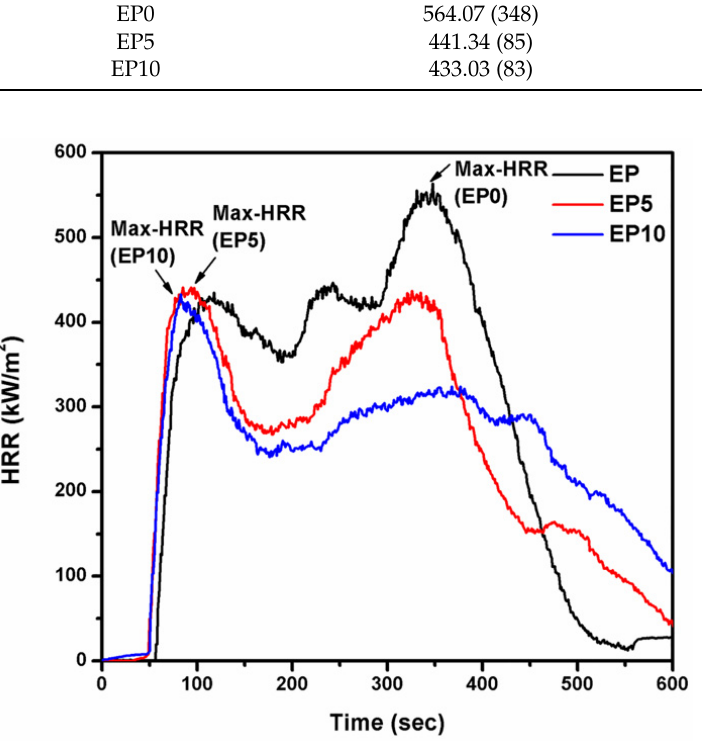
Figure 6. Max-HRR points versus burning time for EP Figure 6. Max ‐ HRR points versus burning time for EP series. Table 3. Cone calorimeter data of EP series.